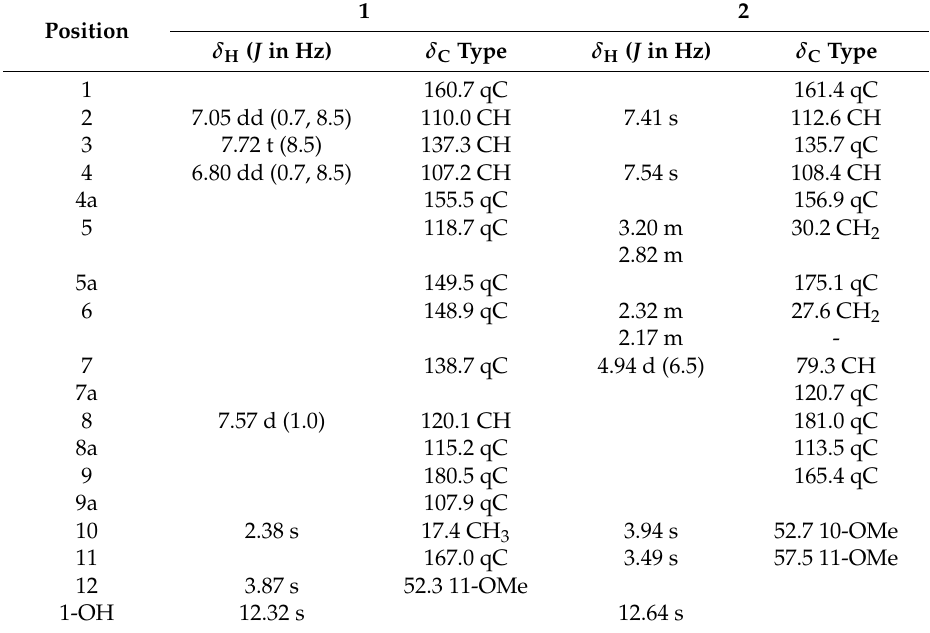
Table 1. 1 H (500 MHz) and 13 C (125 MHz) NMR and HMBC data for 1 (DMSO- d 6 ) and 2 (CDCl 3 ).